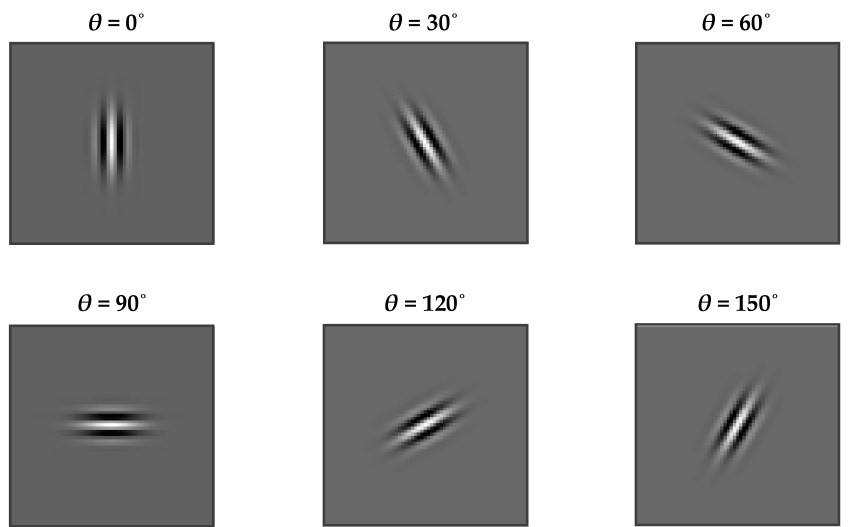
Figure 3. Visualizations of the real part of the Gabor function with the frequency F = 0.18 and orientation angles θ ∈ {0, 30, 60, 90, 120, 150}°.